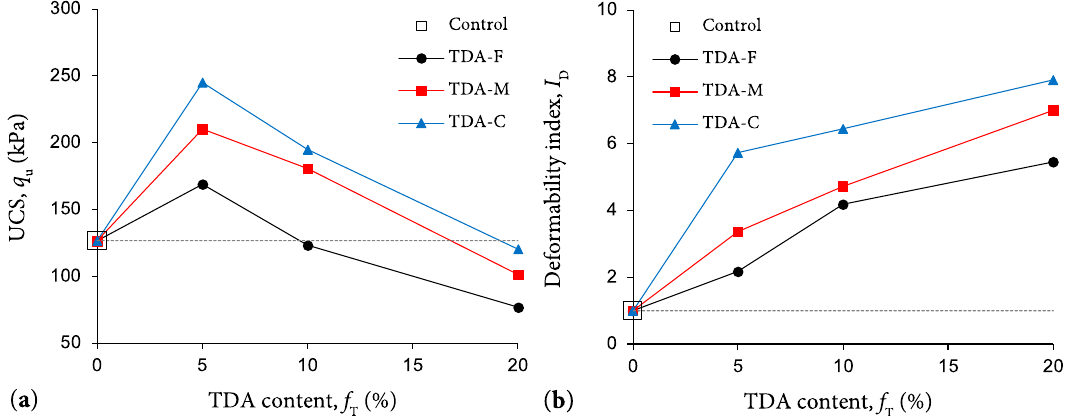
Figure 8. Variations of the ( a ) UCS q u and ( b ) deformability index I D against TDA content f T for the tested mix designs.